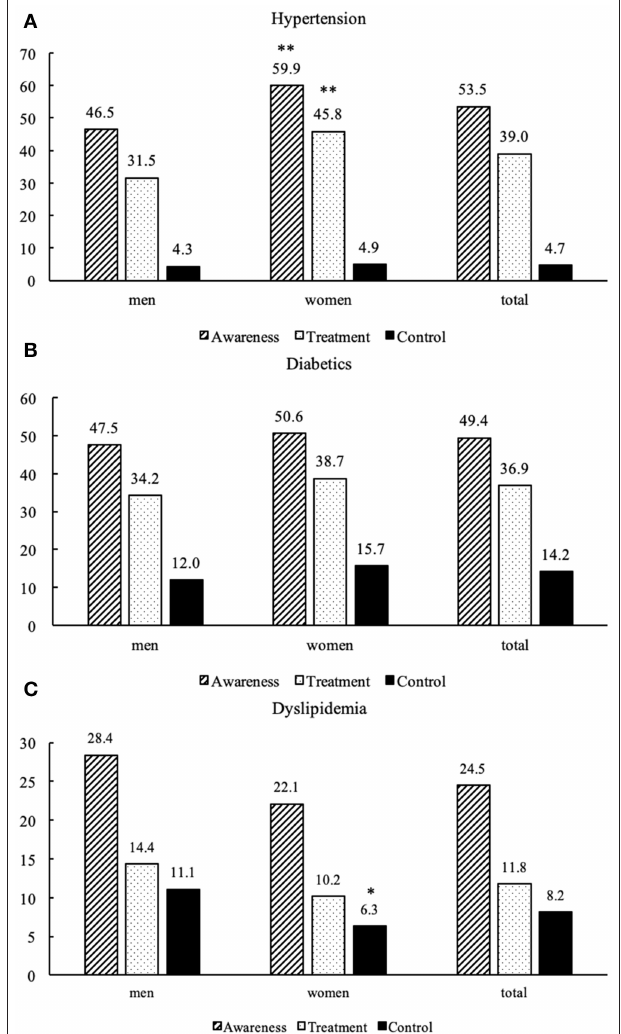
FIGURE 3 | Awareness, treatment, and control of hypertension (A) , diabetics (B) , and dyslipidemia (C) among participants with carotid atherosclerosis in rural Northeast China. ** p < 0.001 indicates women vs. men; * p < 0.05 indicates women vs.